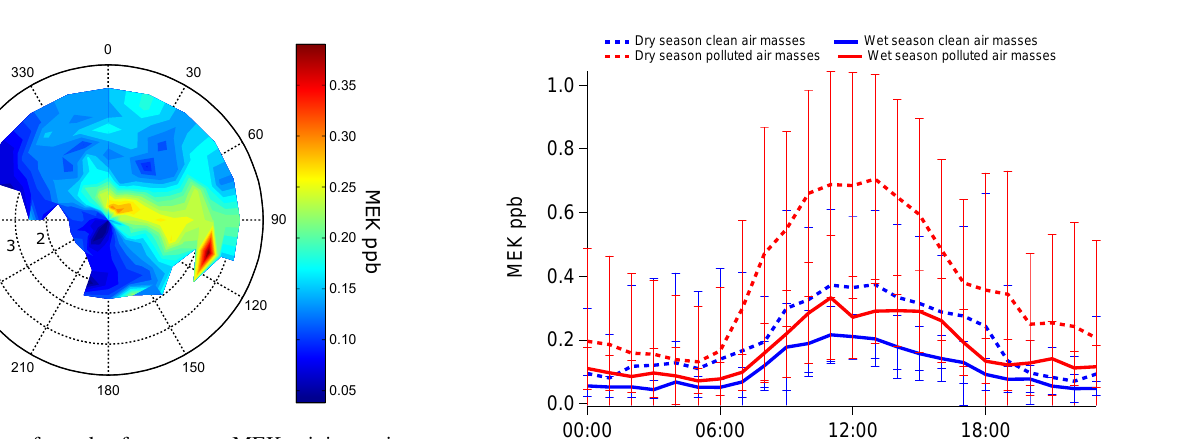
Figure 5. Hourly average diel cycles of MEK at the T2 (left) and CYPHEX (right) sites, for the period of measurements (wet season 2014 for T2 at 14m, July and August 2014 for CYPHEX at 12m). For T2 a separation between polluted (dotted black line) and clean (thick blue line) air masses was done. Hourly mean diel cycles of temperature and PAR are also shown in red and grey, respectively. Error bars represent the standard deviations.